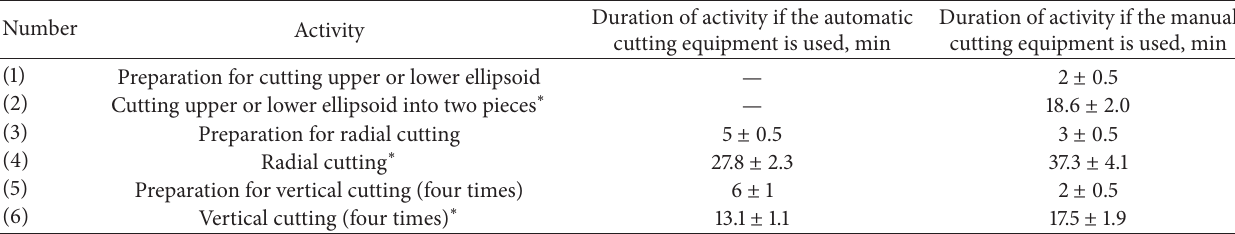
Table 1: Workers operations and corresponding duration for dose calculation.